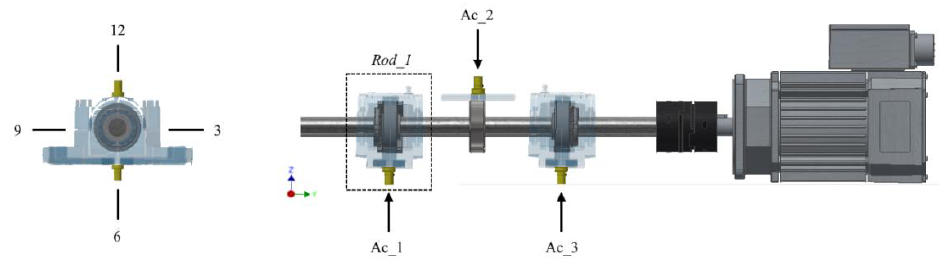
Figure 10. Positioning and orientation of accelerometers.